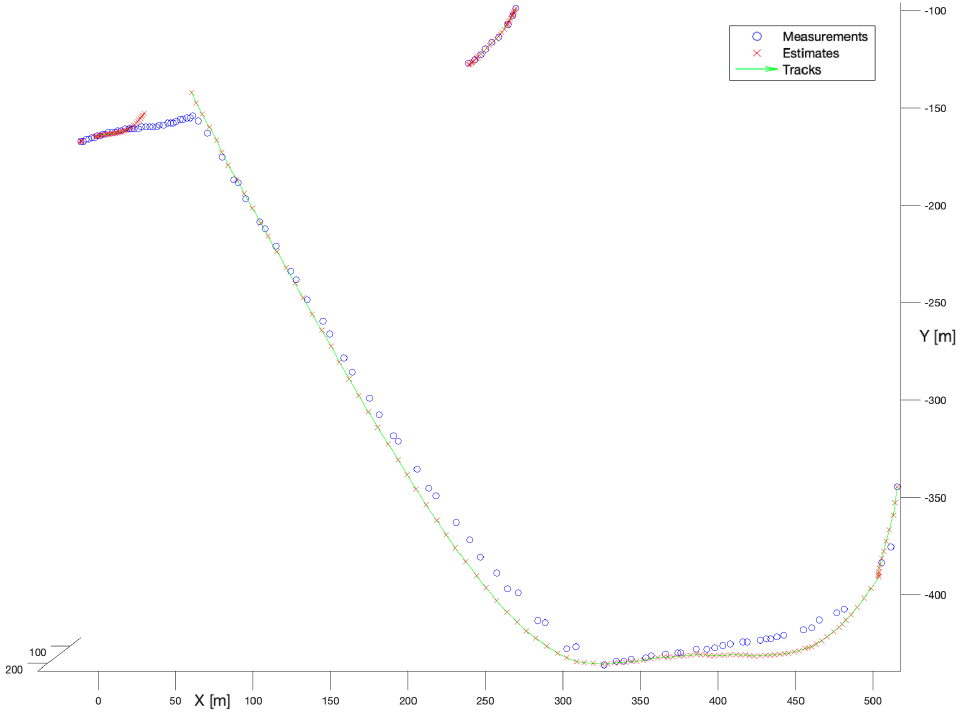
Figure 8. Kalman Filter, known process noise covariance. Multiple bird flight scenario.